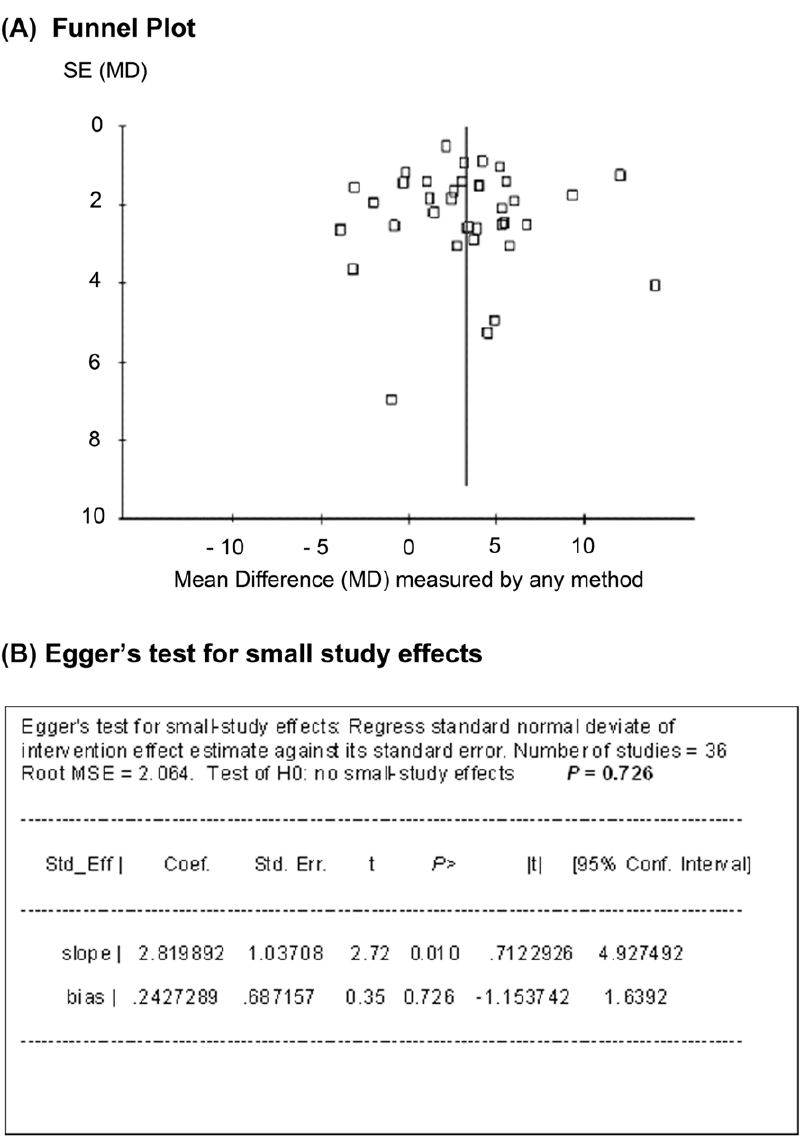
Figure 1. Assessment of risk of bias due to publication and study size on LVEF. (A) Funnel plot and (B) Egger’s test. No significant risk of publication bias or small study effects was observed.